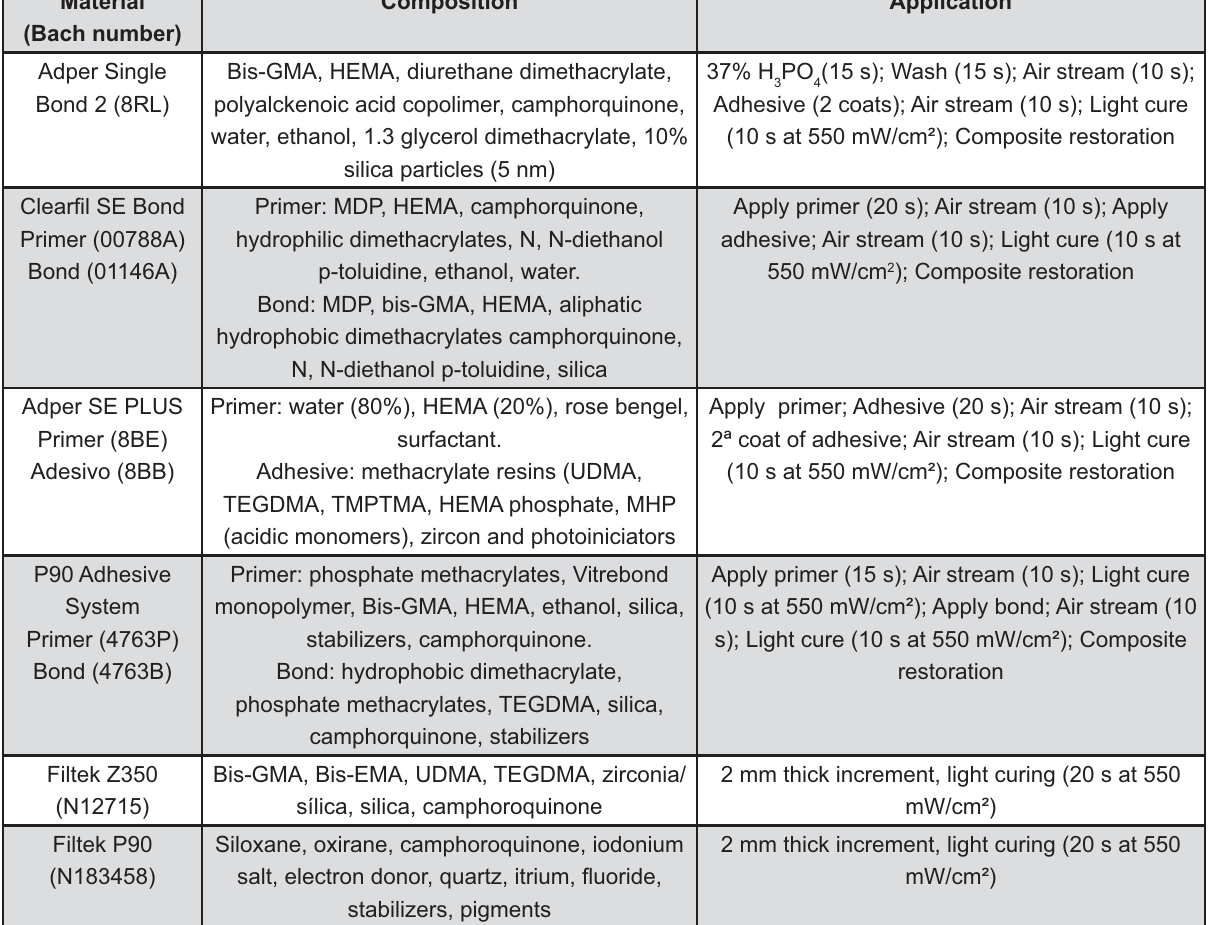
HEMA (2-hydroxyethylmethacrylate); UDMA (urethane dimethacrylate); TEGDMA (triethyleneglycol